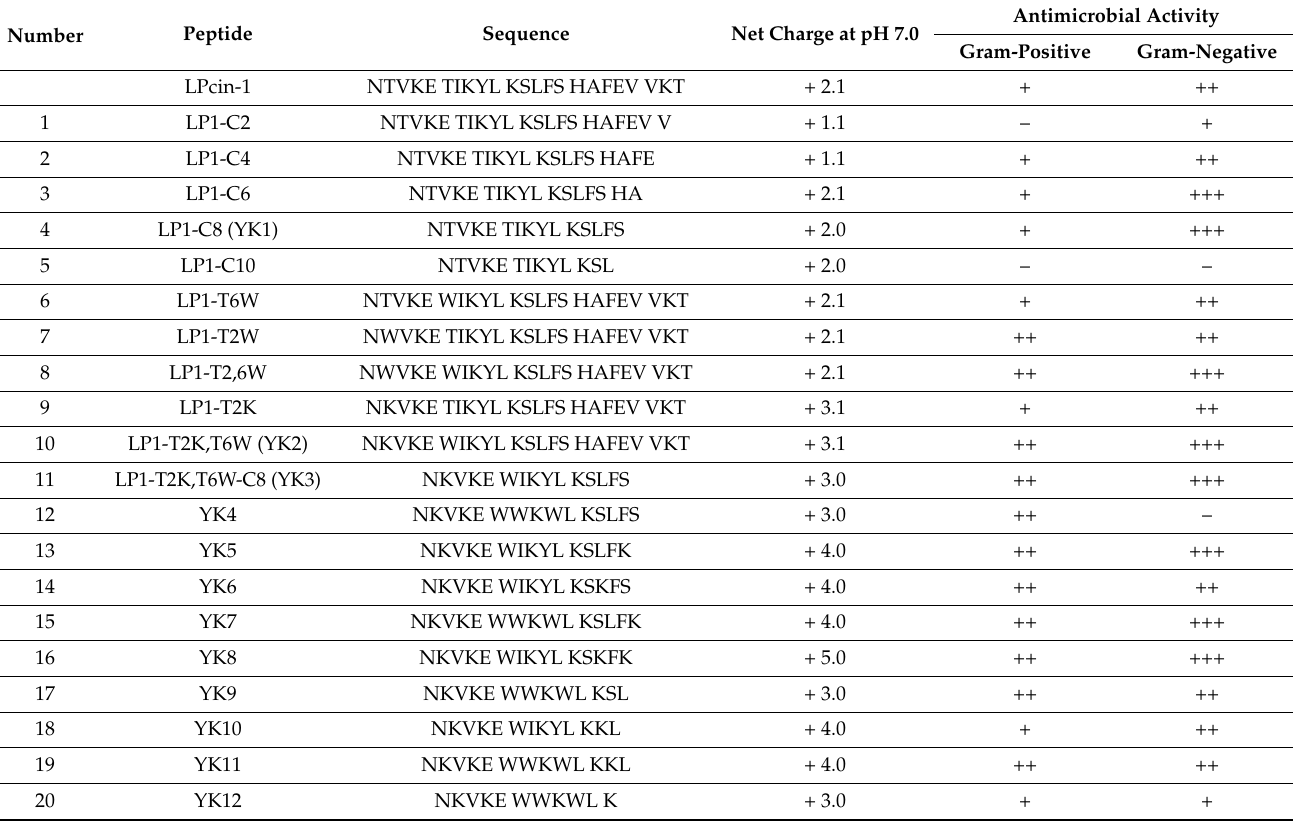
Table 1. Amino acid sequences of Lactophoricin-I (LPcin-I) and its synthetic